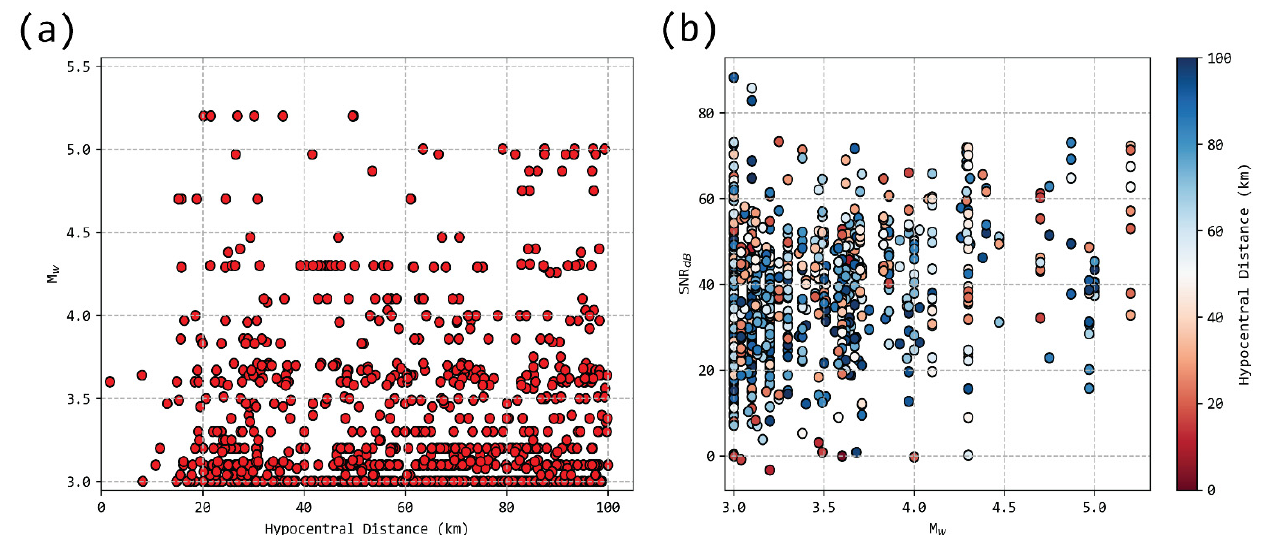
Figure 3. Distribution of available event-station pairs, shown by the relation of magnitude (M w ) to the hypocentral distance ( a ) and SNR (in dB) as a relation of magnitude and the hypocentral distance ( b ).